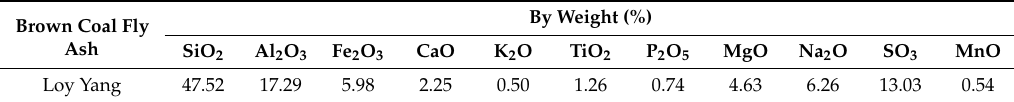
Table 1. The chemical composition.